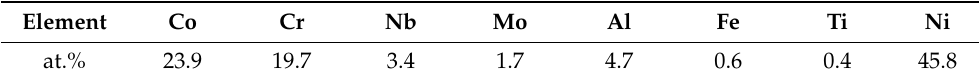
Table 1. Chemical composition of the investigated VDM ® Alloy 780 samples measured by spark spectrometry.